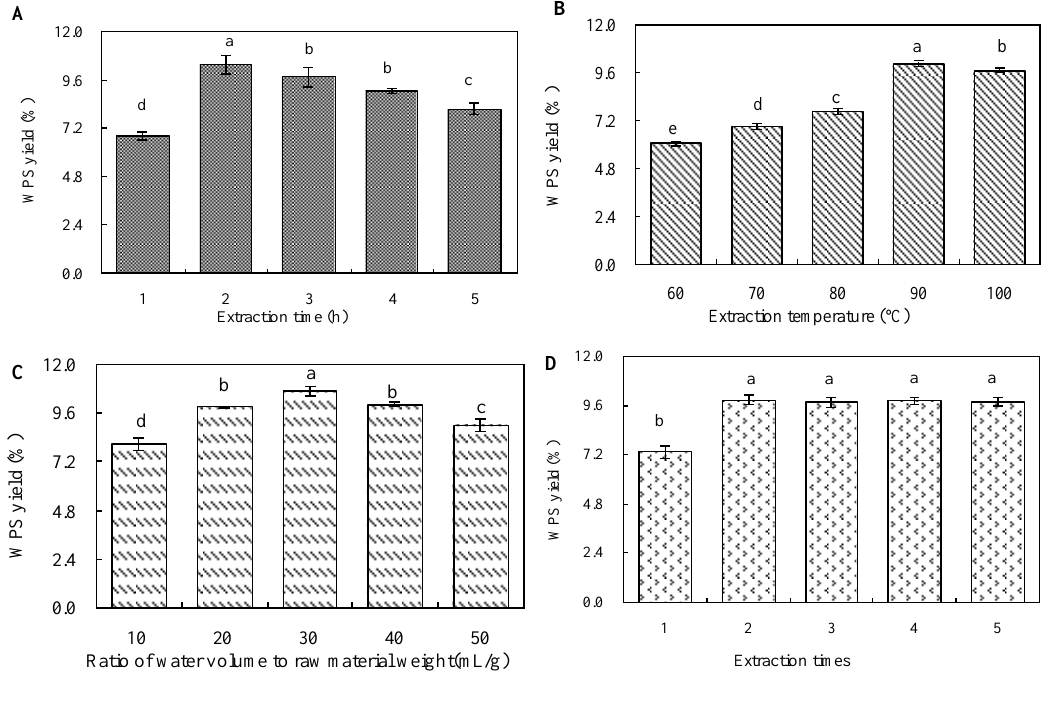
Figure 1. Effects of extraction time ( A ), extraction temperature ( B ), ratio of water volume (mL) to raw material weight (g) ( C ), and number of extractions ( D ) on water-extracted mycelial polysaccharide (WPS) yield. The error bars represent standard deviations from three independent samples. Different letters indicate significant differences among the treatments at p = 0.05